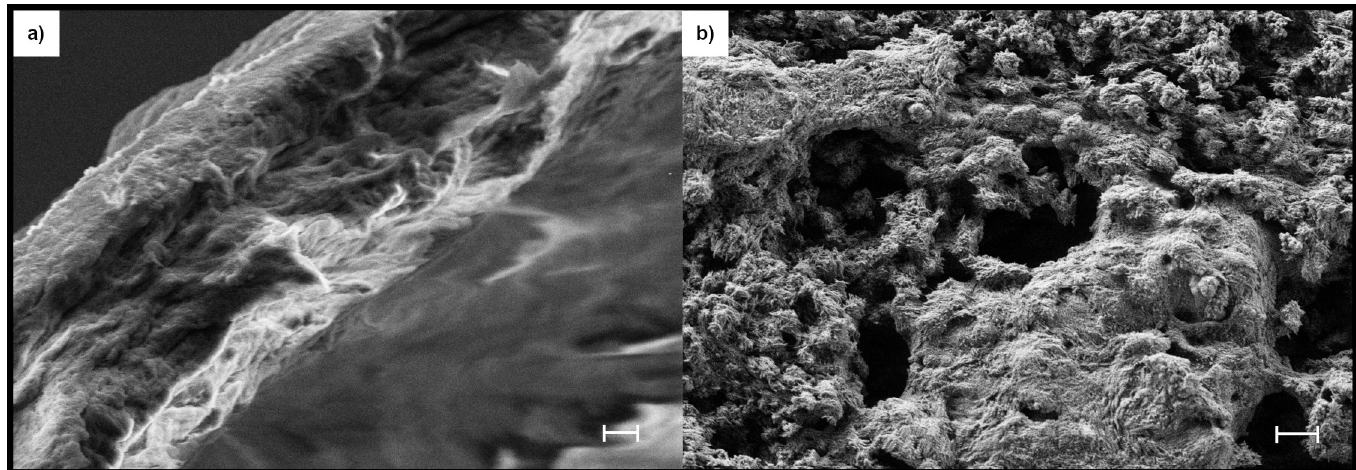
Fig 2. Collagen and mineral deposited during ring culture. Constructs at termination (Day 63) were differentially processed (see Methods) to expose just collagen (a) or just mineral (b) and visualized by SEM. Cut edges of the ring constructs are presented to allow visualization of the constructs’ interior and part of the surface. SEM settings for (a): EHT = 5 KeV, WD = 4.7 mm, H = 30 μ m, W = 40 μ m, Mag = 2.96 K X. Scale Bar = 2 μ m. SEM settings for (b): EHT = 3 KeV, WD = 2.1 mm, H = 122.7 μ m, W = 163.6 μ m, Mag = 699 X. Scale Bar = 10 μ